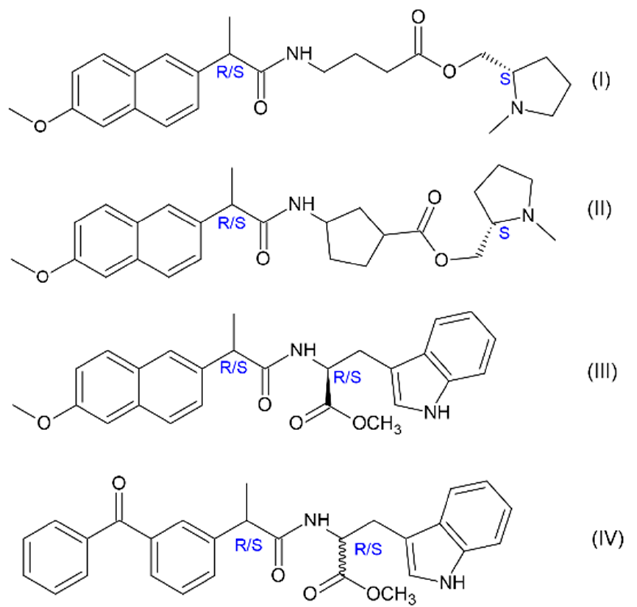
Figure 1. Chemical structure of chiral systems demonstrating spin selectivity.